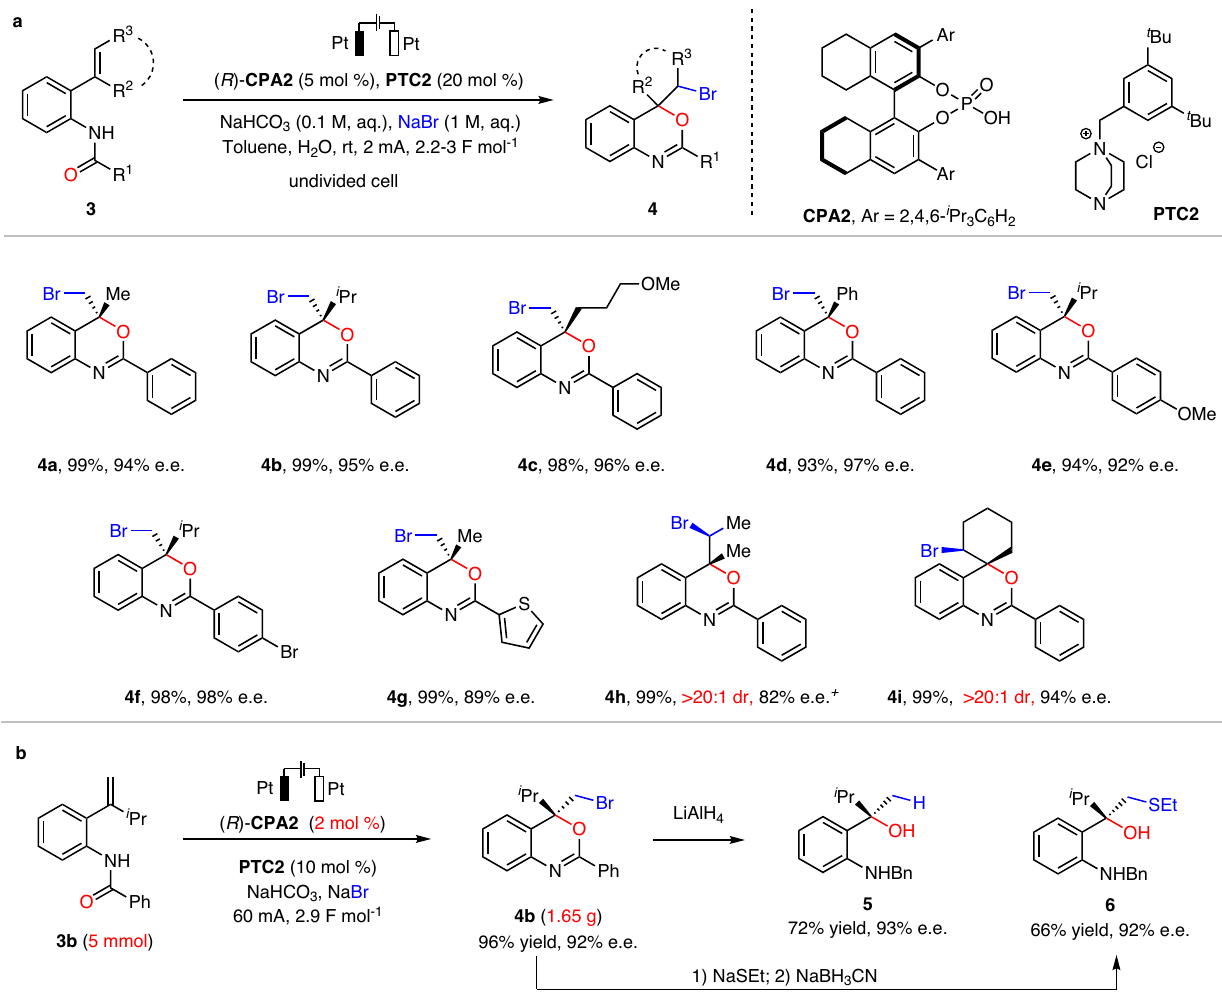
Fig. 3 | Reaction conditions, scope and application of electricity-driven asym- metricbromocyclizationof2-amidostyrenes.a Reactionscale: 3 (0.3mmol), ( R )- CPA2 (5mol %), PTC2 (20mol %), NaHCO 3 (0.1M in H 2 O), NaBr (1.0M in H 2 O), toluene (6mL), H 2 O (5mL), Pt anode and cathode (10mm×10mm×0.2mm),